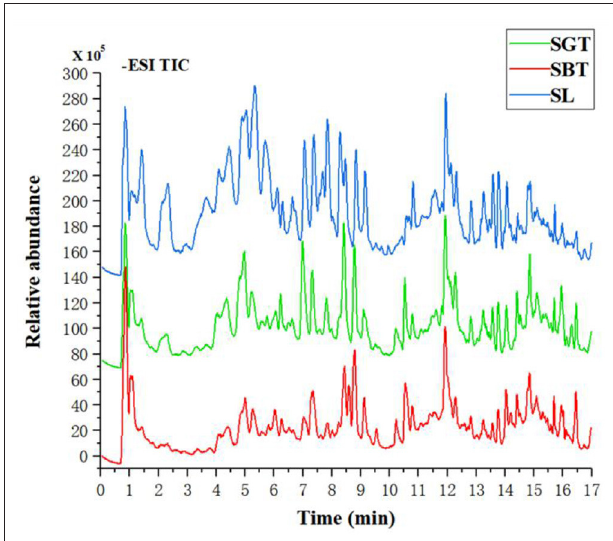
FIGURE 2 | The total ion chromatograms of SL, SGT, and SBT of liquid chromatography-mass spectrometry (LC-MS) in the negative ion